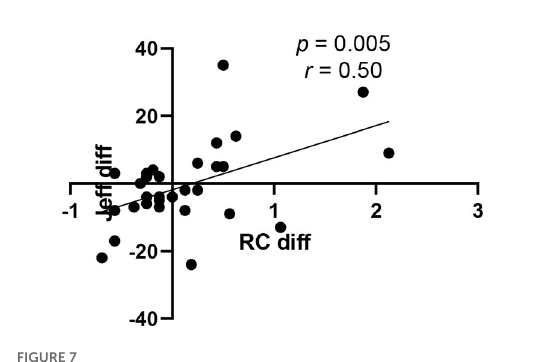
FIGURE7 Correlation between individual changes in JSE and RC scores of students in UT. Each UT student’s change in their JSE score between August and December is shown on the Y-axis (Jeff diff), while the change in the same student’s RC score (RC diff) is plotted on the x-axis ( n =